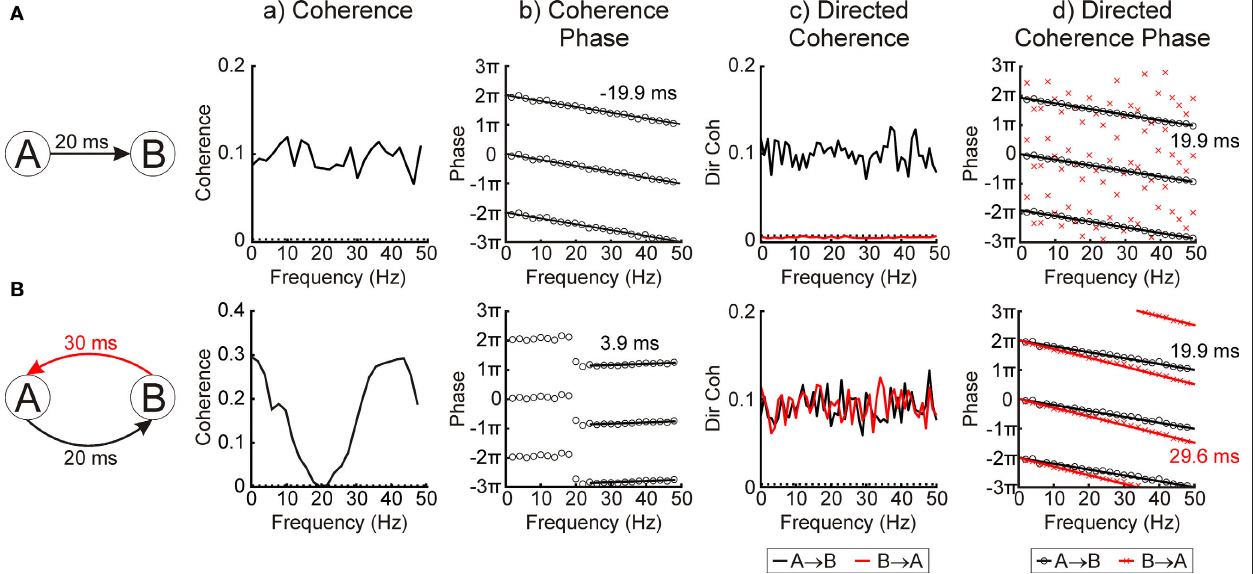
(b) coherence phase spectra. Phase plotted three times to avoid wrap-around effects. Black lines show best fit with text indicating the phase delay. (c) directed coherence spectra. Dotted lines show 95% significance level. (d) directed coherence phase spectra. Phase plotted three times to avoid wrap-around effects. Black lines show best fit with text indicating the phase